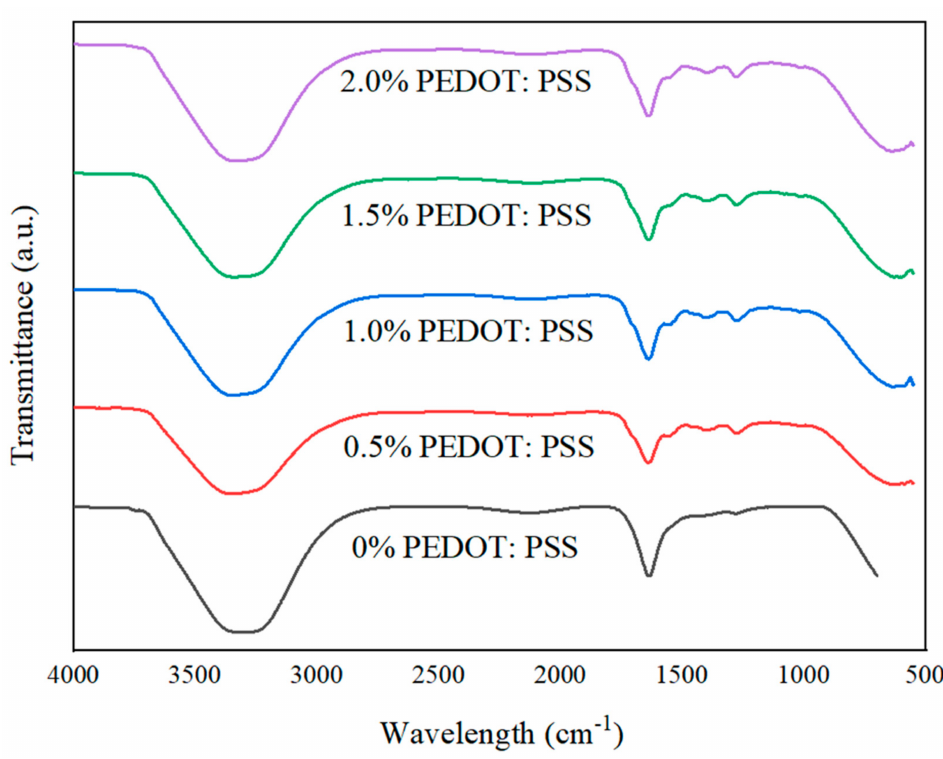
Figure 13. ATR–FTIR plots of fabricated porous hydrogels.